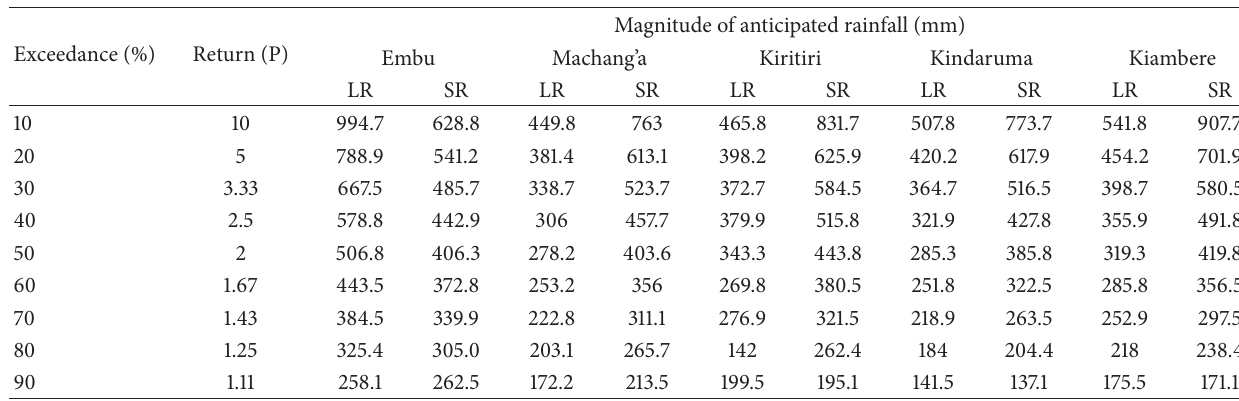
Table 4: (a) Probability of rainfall exceedance and return-periods for the LRs and SRs in the study area. (b) Probability of average seasonal months’ rainfall exceedance and return-periods for the LRs and SRs in Mbeere subcounty.